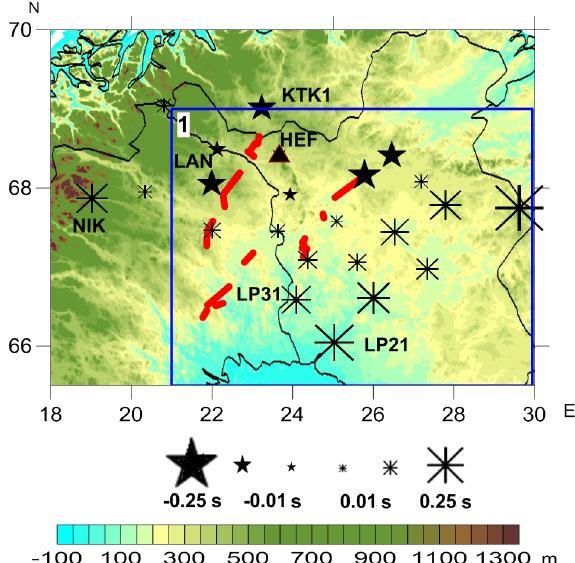
Figure 6. The time station corrections imposed on a topographic map ETOPO1 (Amante and Eakins, 2009) and computed with re- spect to the reference station HEF by VELEST. Stars denote nega- tive corrections, snowflakes denote positive corrections. The size of the symbol (star or snowflake) is proportional to the value of cor- rection. The red lines denote postglacial faults. Blue box indicates Region 1. The full names of faults are the same as in Fig. 1b.